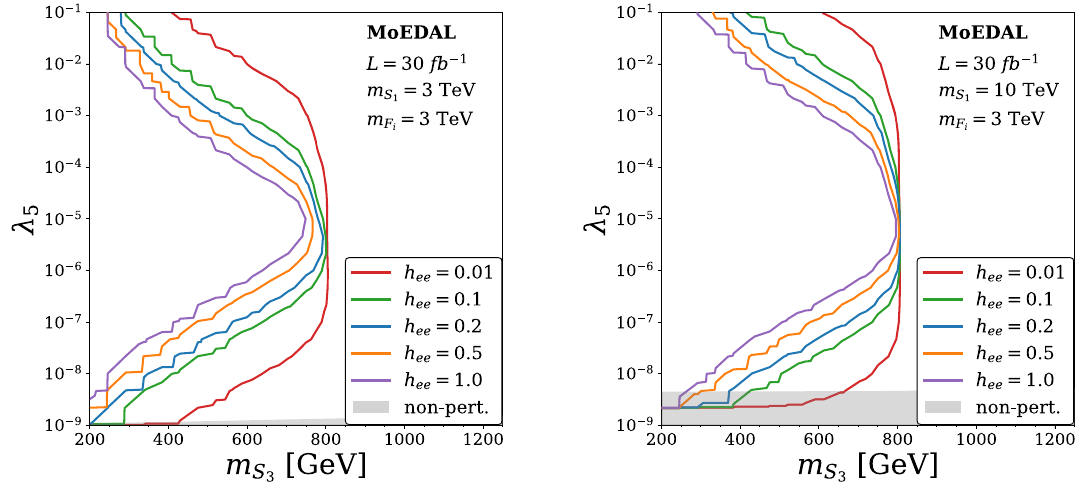
= 3 and 10 TeV in the left and right plots, respectively. We assume 1